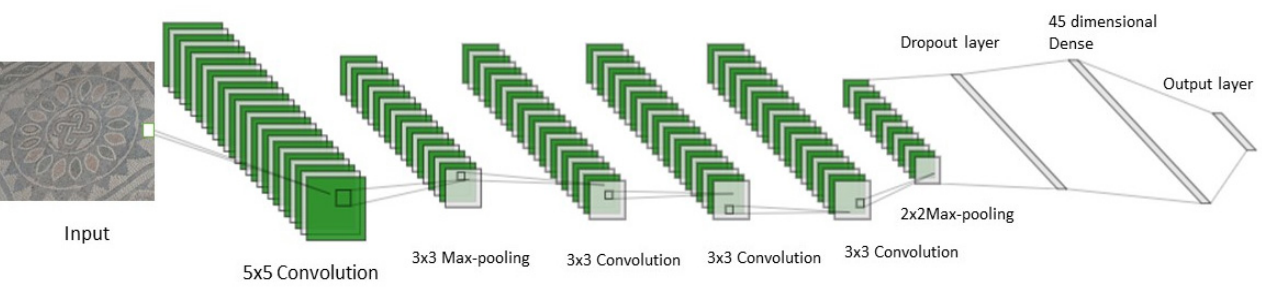
Figure 2. The proposed CNN architecture.